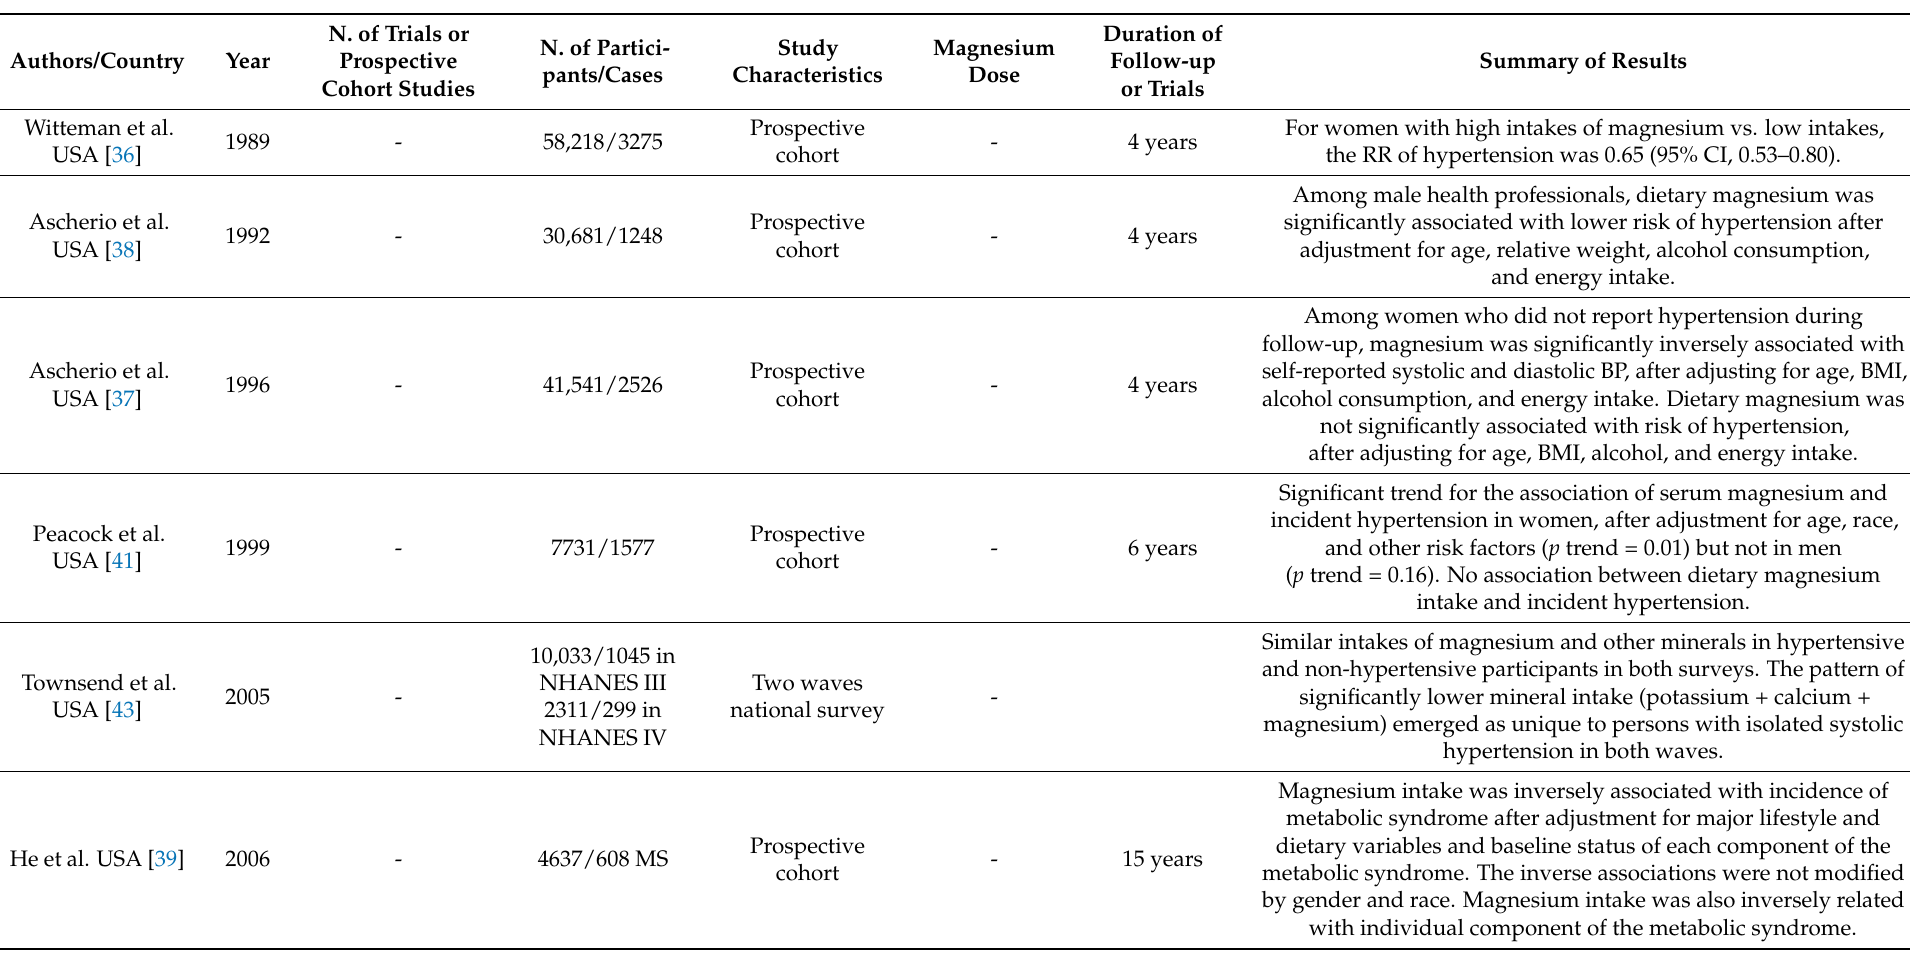
Table 4. Summary of results from prospective studies and meta-analyses of trials and cohort studies on the association of magnesium and hypertension included in the review.